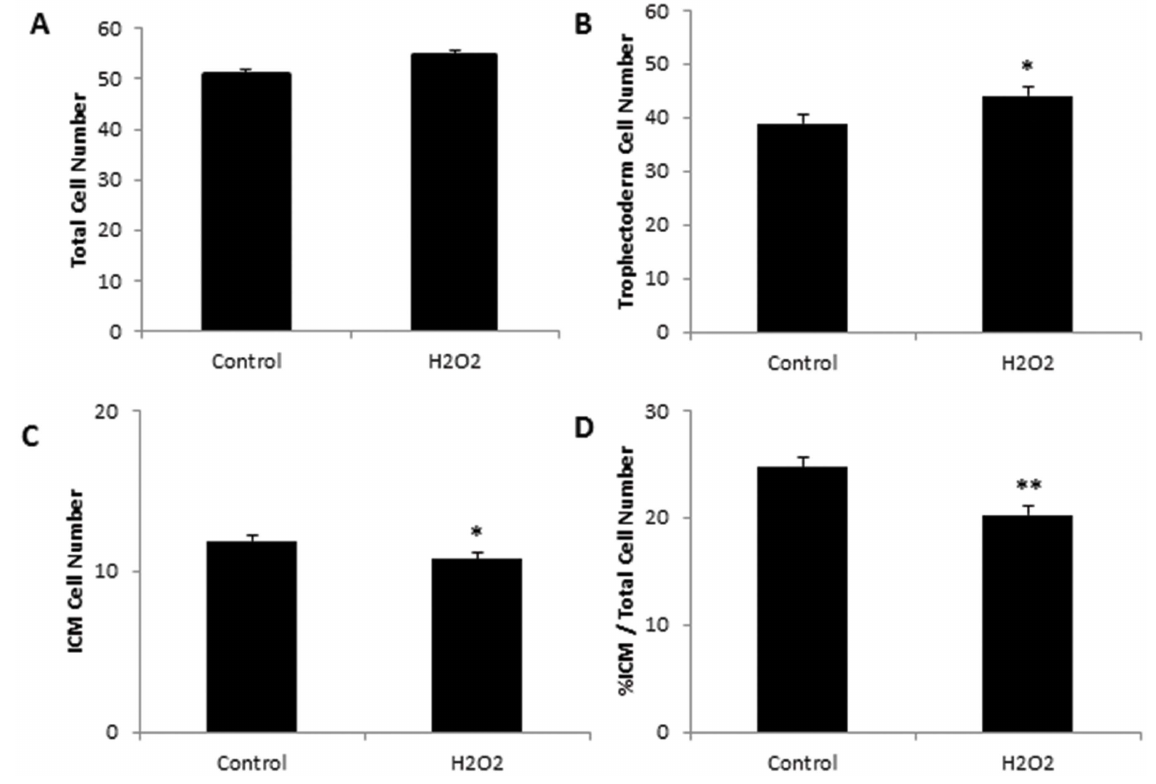
Figure 1. Effect of treating sperm with 1500 m M H 2 O 2 on subsequent (A) blastocyst cell number, (B) trophectoderm cell number, (C) inner cell mass (ICM) cell number, (D) percentage (%) of ICM/total cell number. Control (n=84 embryos), H 2 O 2 (n=79 embryos). Values are mean 6 SEM. * Indicates significantly different from control (P , 0.05) ** indicates significantly different from control (P , 0.01). doi:10.1371/journal.pone.0100832.g001 PLOS ONE |